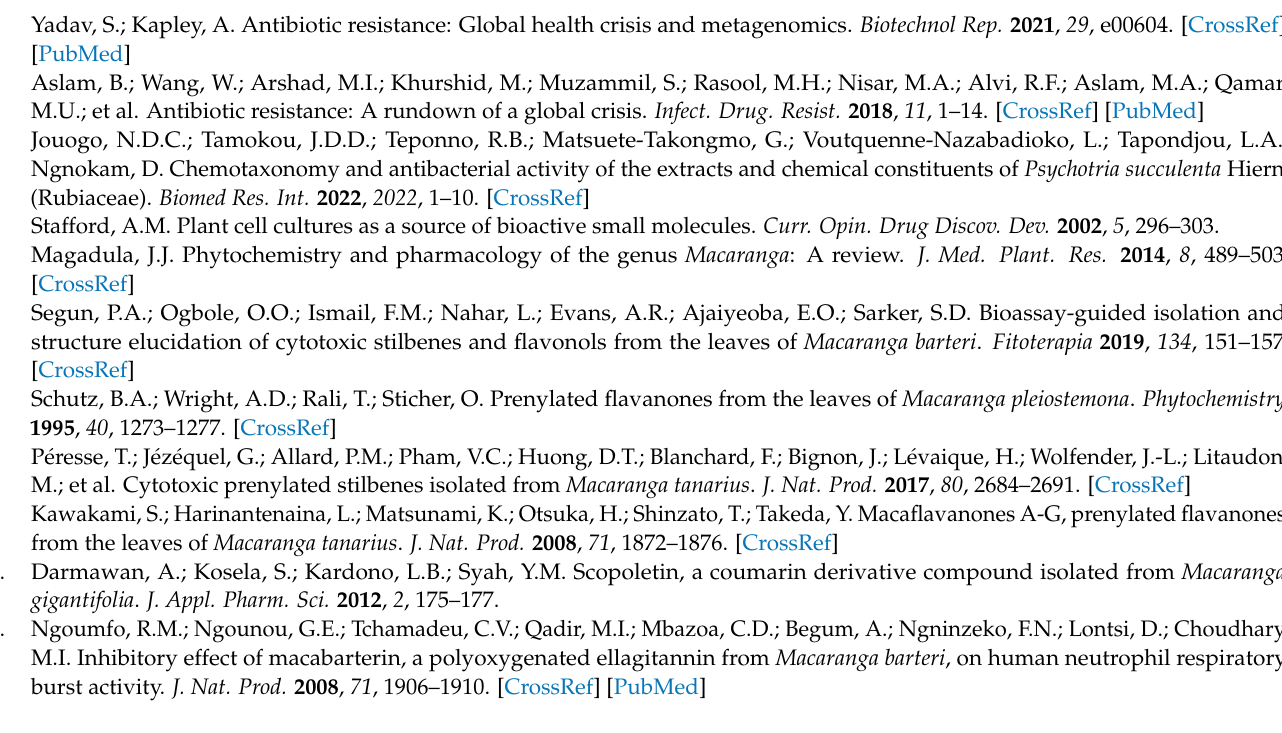
of 6b; Figure S13: 1 H- 1 H COSY spectrum of 6b; Figure S14: HSQC spectrum of 6b; Figure S15: HMBC spectrum of 6b; Figure S16: ESI-HR Mass spectrum of 6c; Figure S17: 1 H-NMR (500 MHz, acetone – d 6 ) spectrum of 6c; Figure S18: 13 C-NMR (125 MHz, acetone – d 6 ) spectrum of 6c; Figure S19: DEPT 135 spectrum of 6c; Figure S20: 1 H- 1 H COSY spectrum of 6c; Figure S21: HSQC spectrum of 6c; Figure S22: HMBC spectrum of 6c; Figure S23–S57: 1 H and 13 C-NMR data of compounds 1–17 ; Scheme S1: Protocol of extraction and isolation of compounds from M.